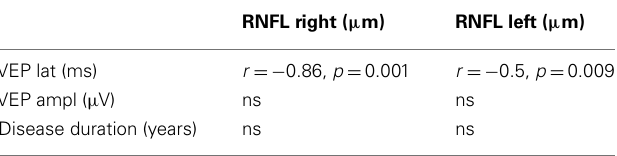
Table 6 | Correlation of RNFL withVEP and disease duration